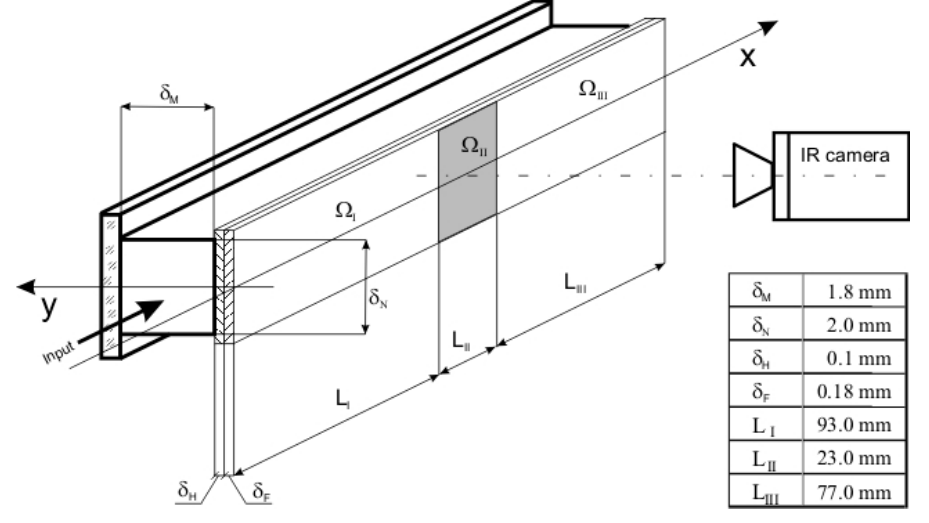
Figure 3. The characteristic dimensions of the mini-channel.